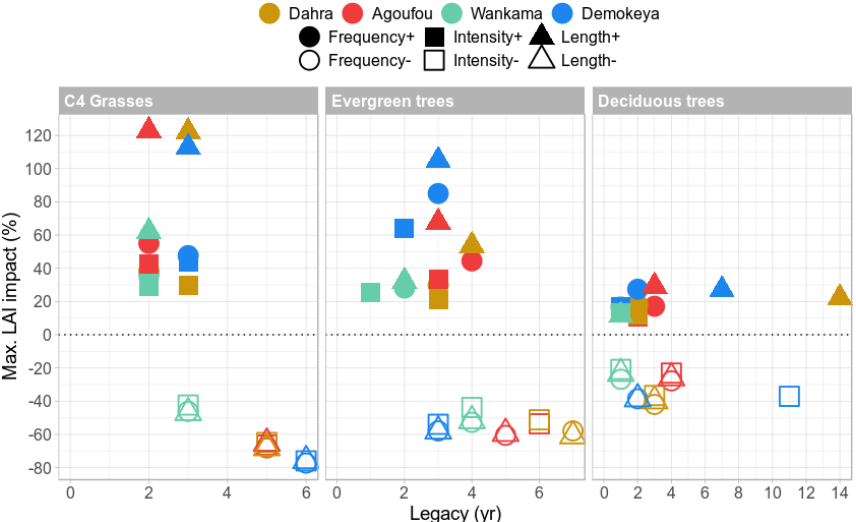
Figure 8. Summarized overview of the vegetation response to the different rainfall scenarios for all sites, showing the maximum impact (%) on the LAI for each PFT, along with its legacy (years), which is defined as the last year for which the impact is 1 standard deviation away from the reference value. Sites are represented by different colours; scenarios are represented by